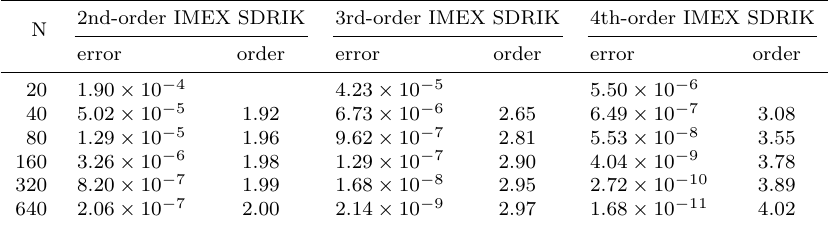
Table 3. Accuracy test with the van der Pol equation for the IMEX SDIRK(a) methods. The first column displays the number of steps (N).